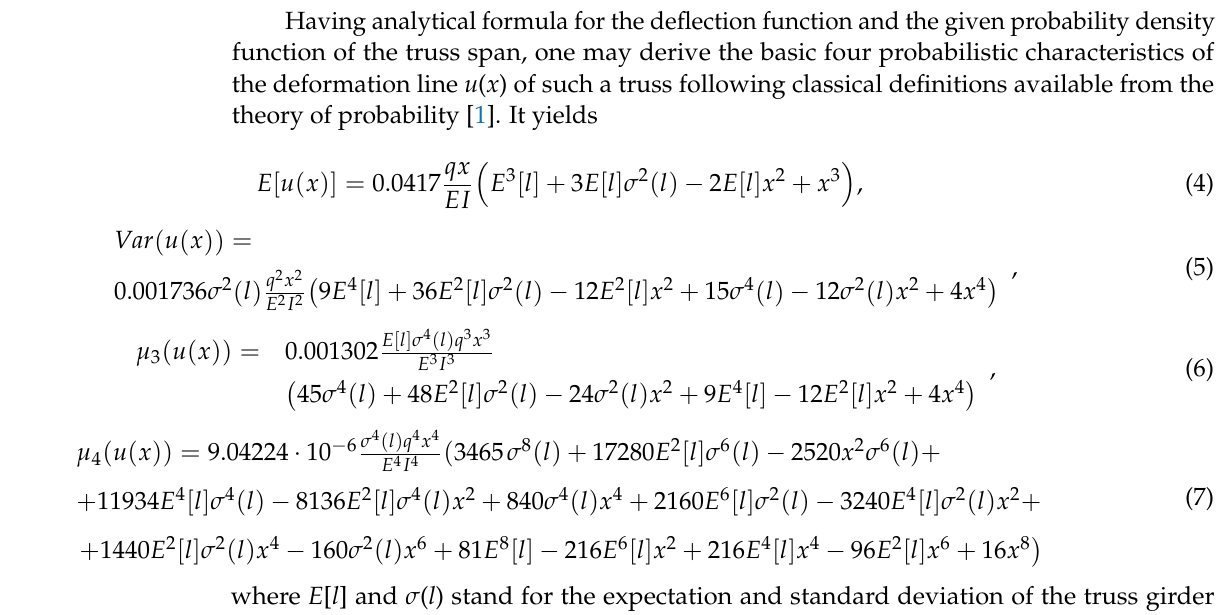
Figure 3. Symbols used for analytical